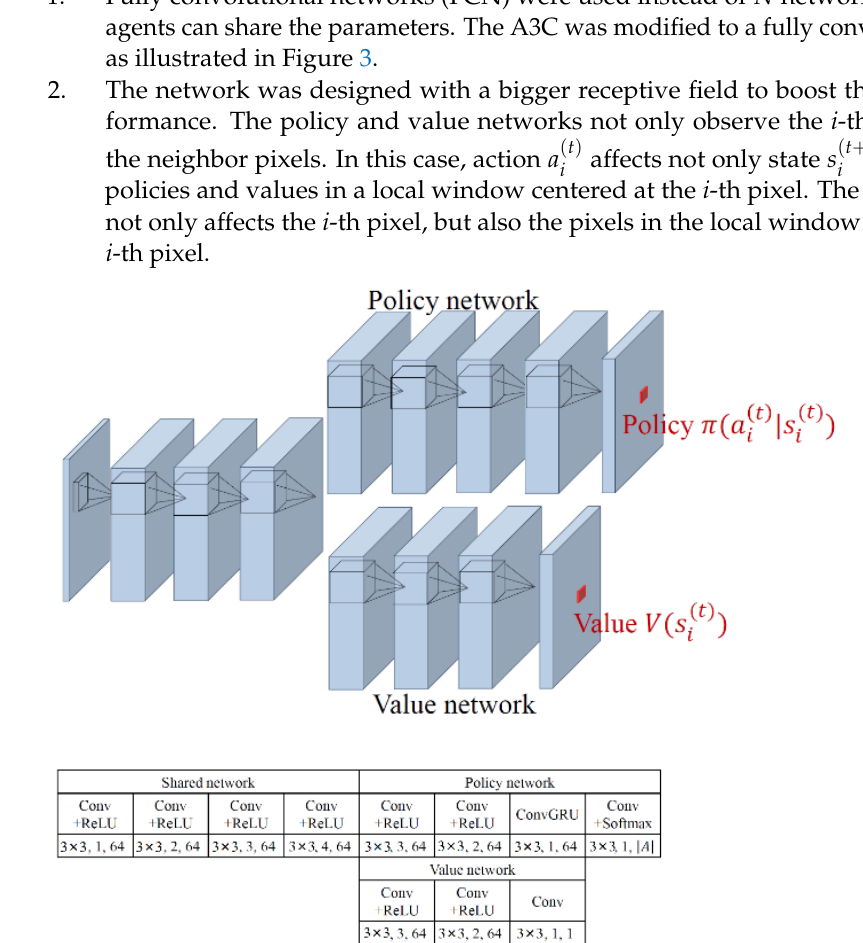
Figure 3. PixelRL network architecture [28]. The numbers in the table indicate the filter size, dilation factor, and output channels, respectively.